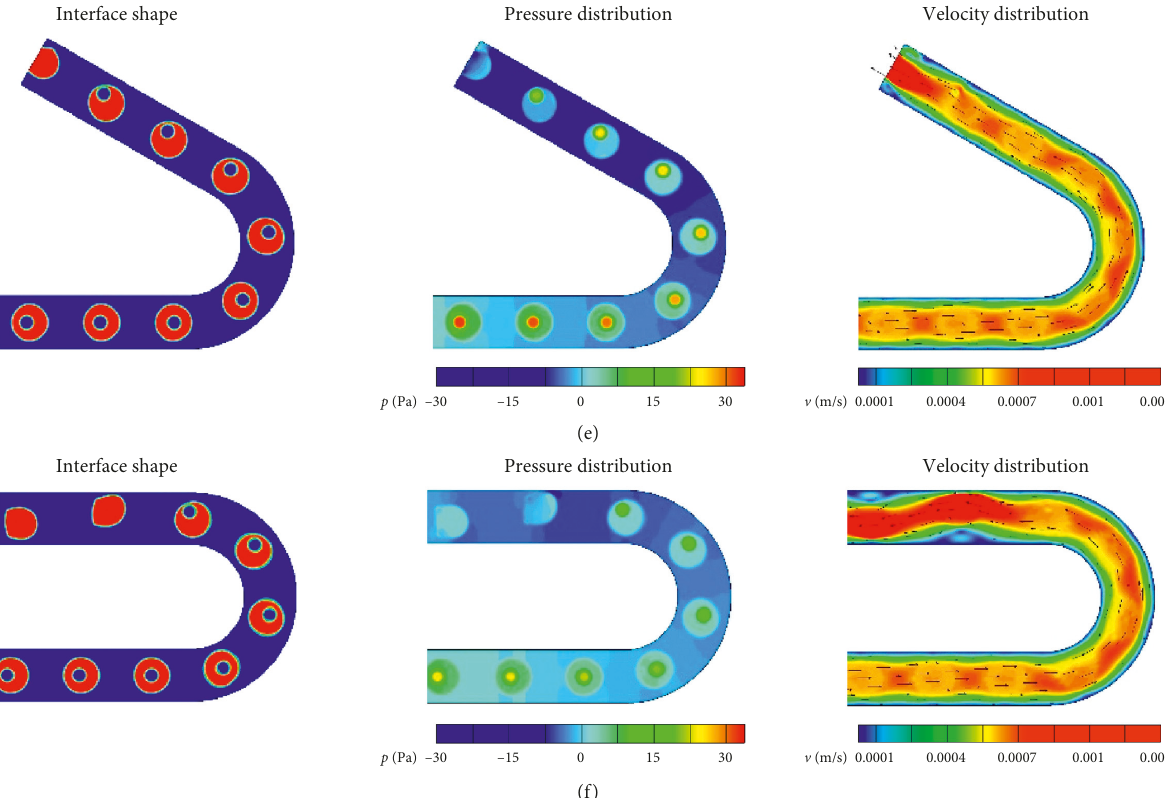
Figure 6: Effect of curved angle on the compound droplet deformation: (a) θ � 30 ° ; (b) θ � 60 ° ; (c) θ � 90 ° ; (d) θ � 120 ° ; (e) θ � 150 ° ; (f) θ � 180 ° .